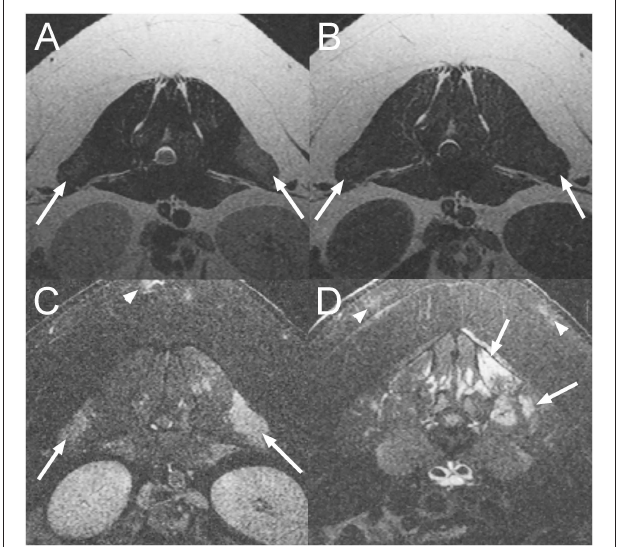
FIGURE 1 | Transverse T2-weighted (T2W) (A) , T1-weighted (T1W) (B) , and post contrast T1W images with fat suppression (C,D) at the level of L1-2 intervertebral disc space (A–C) and L5 vertebra (D) of an 18-month-old pig diagnosed with a myopathy secondary to Erysipelothrix rhusiopathiae infection (Case 1). There are multifocal T2W hyperintense and T1W iso- to mildly hyperintense lesions when compared to normal muscle in the epaxial musculature of the lumbar vertebral column which are strongly contrast enhancing (arrows). Similar lesions are also associated with the subcutaneous fat